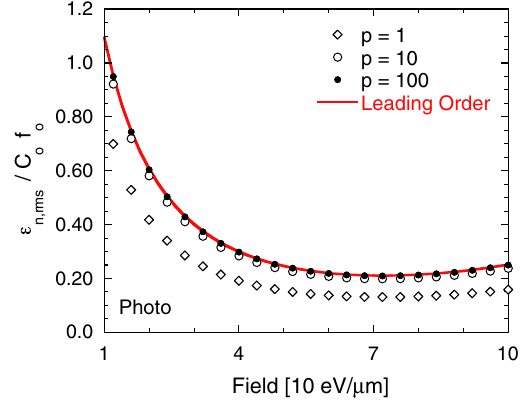
FIG. 7. Same as Fig. 6 but for parameters typical of photo- emission in Table